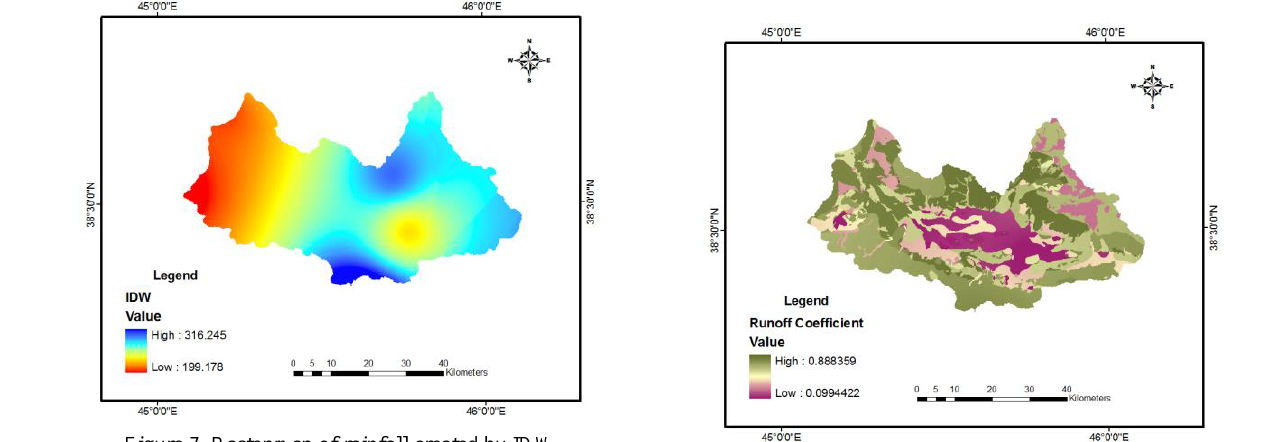
Figure 7. Raster map of rainfall created by IDW